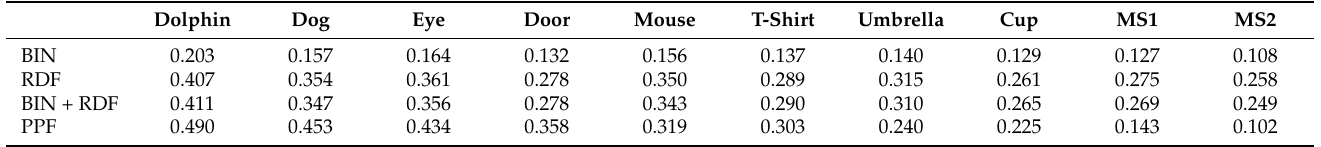
Figure 5. Results of the visualized features (from left to right): FM, BIN, RDF, BIN + RDF, and PPF. Table 1. Similarity values between the FM and the BIN, RDF, BIN + RDF and PPF image features. All p -values were significantly lower than